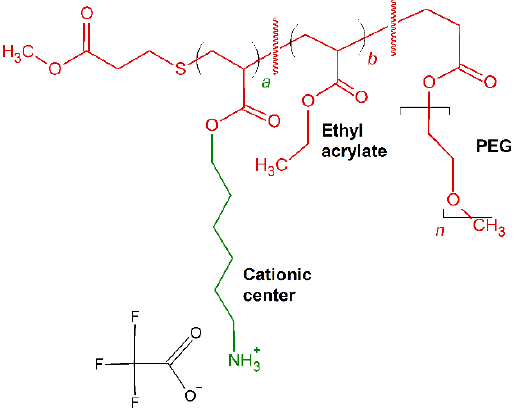
Figure 8. Schematic representation of P1–P4 polymers. In red: hydrophobic residues, in green: positively charged chains.